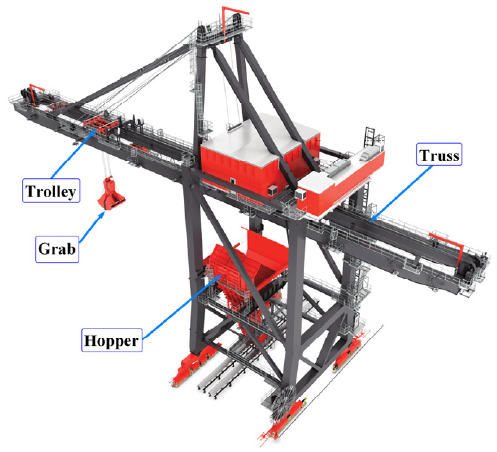
Figure 1. Three-dimensional model of grab ship unloader.